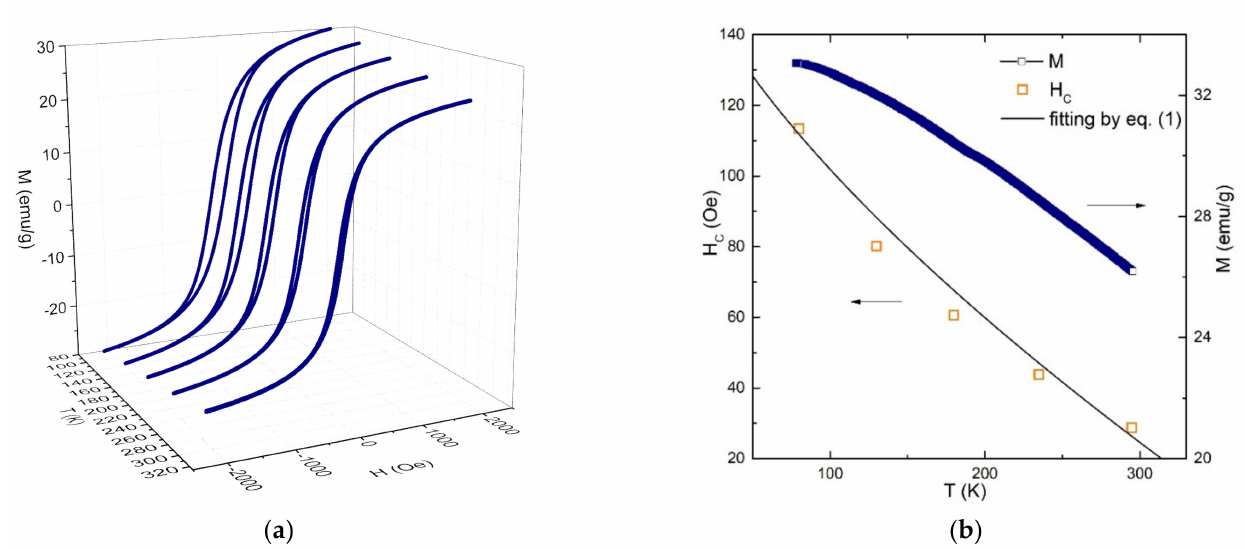
Figure 4. ( a ) Hysteresis loops measured in fields from –2 to 2 kOe in the temperature range of 80–295 K. ( b ) Temperature dependence of the coercivity (orange squares) fitted by Equation (2) (black line) and temperature dependence of magnetization measured in a field of 5 kOe (blue squares).